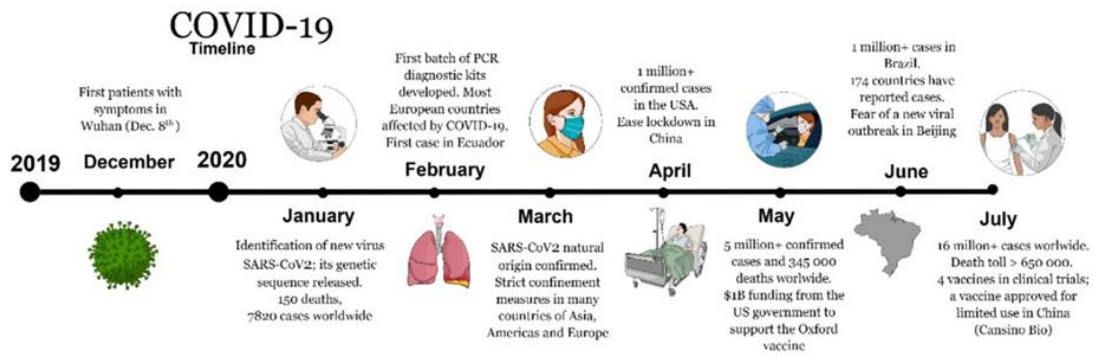
Figure 1. Coronavirus infectious disease (COVID-19) timeline highlighting the most striking